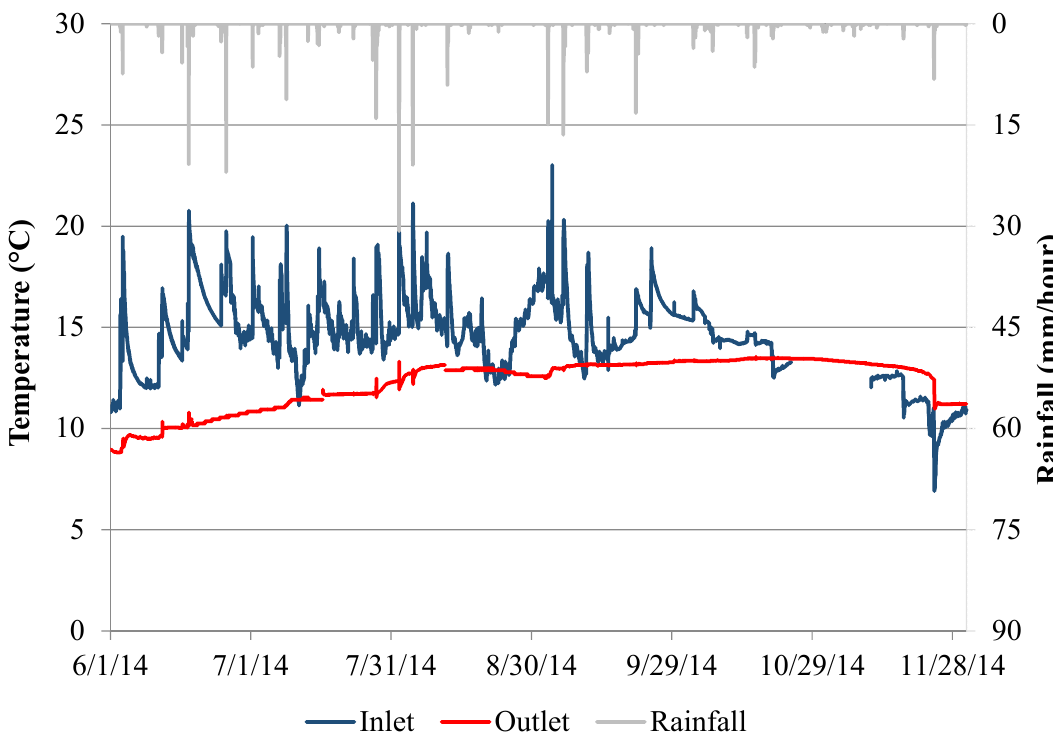
Figure 3. Water temperature over monitoring period (Gap in October inlet temperature is due to malfunctioning equipment).